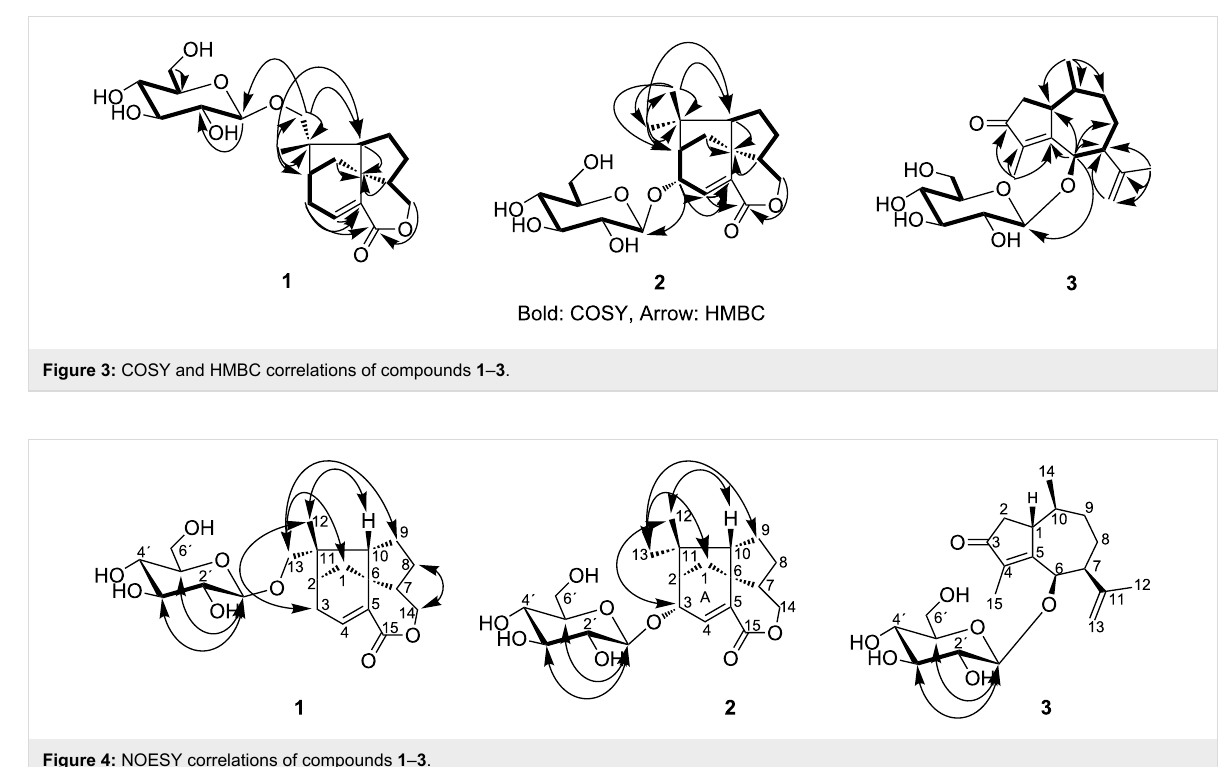
Figure 4: NOESY correlations of compounds 1 – 3 .